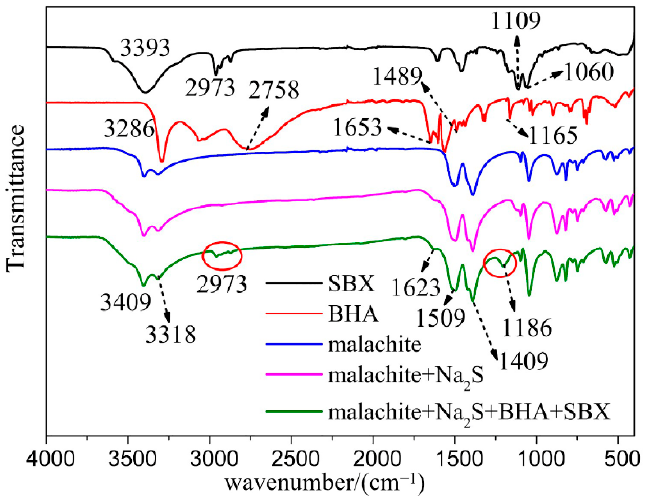
Figure 6. Infrared spectra of malachite before and after the treatment of the mixed collector and Na 2 S, and the infrared spectra of BHA and